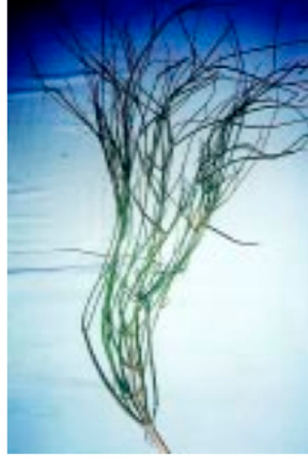
Figure 15. Khimp plant shrub [59].